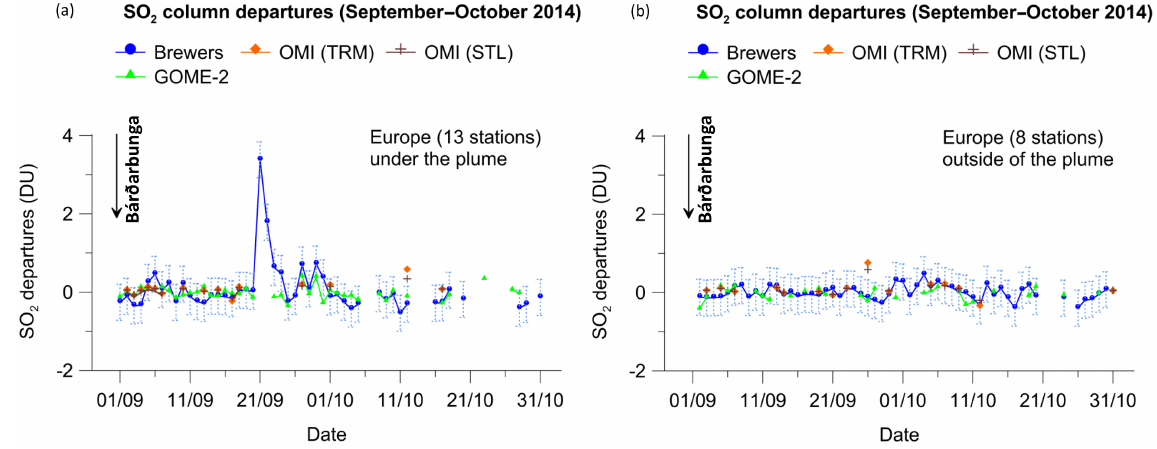
Figure 4. Mean SO 2 column departures from the unperturbed 10-day pre-volcanic baseline measured by Brewers, OMI (TRM, STL) and GOME-2 during September–October 2014 over Europe following the 2014 Bárðarbunga volcanic eruption for (a) stations under the volcanic SO 2 plume and (b) stations outside of the plume. The error bars for the Brewer observations show the standard deviation of all daily values during the unperturbed 10-day period prior to the volcanic eruption. Brewer stations under the plume are Sodankylä, Vindeln, Jokioinen, Oslo, Norrköping, Copenhagen, Obninsk, Manchester, De Bilt, Reading, Uccle, Hradec Králové, Hohenpeißenberg and Aosta. Stations outside of the plume are Warsaw, Belsk, Davos, Arosa, Kislovodsk, Rome and Athens. Each daily average from either OMI or GOME-2 was calculated if and only if more than half of the individual overpasses had data on a given day. The arrow marks the starting date of the eruption (beginning on 31 August 2014 and continuing to be active throughout the whole bimonthly period and